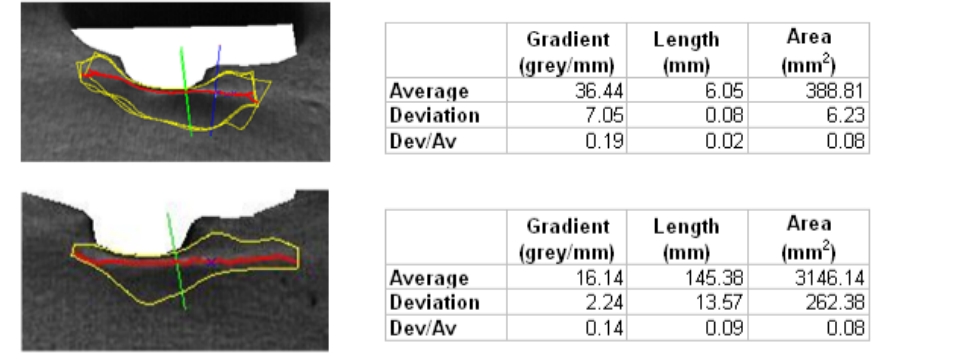
Figure 11. Average values and deviations for different